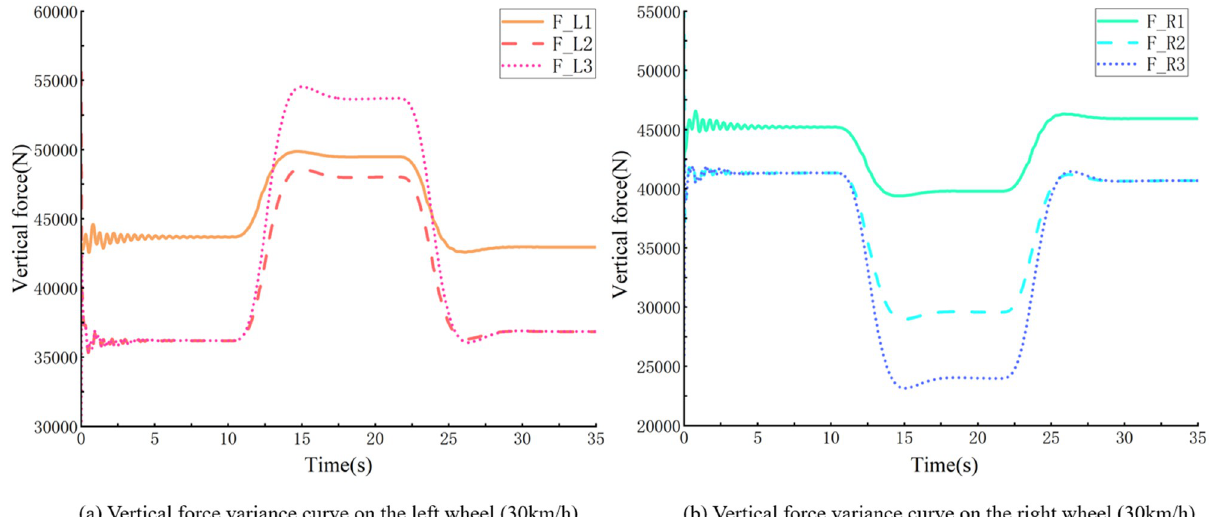
Fig 7. Vertical force curve of vehicle’s left and right wheels bending (30 km / h ).